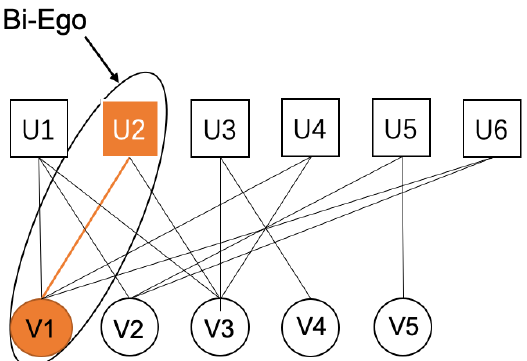
Figure 6. Bi-EgoNet microscopic network model of node pairs ( U 2 , V 1 )